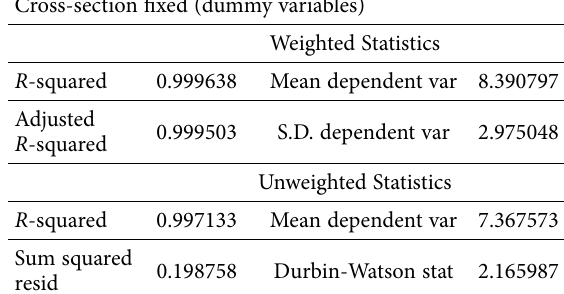
Table 7. Estimation equation for gross operating surplus across autonomous regions